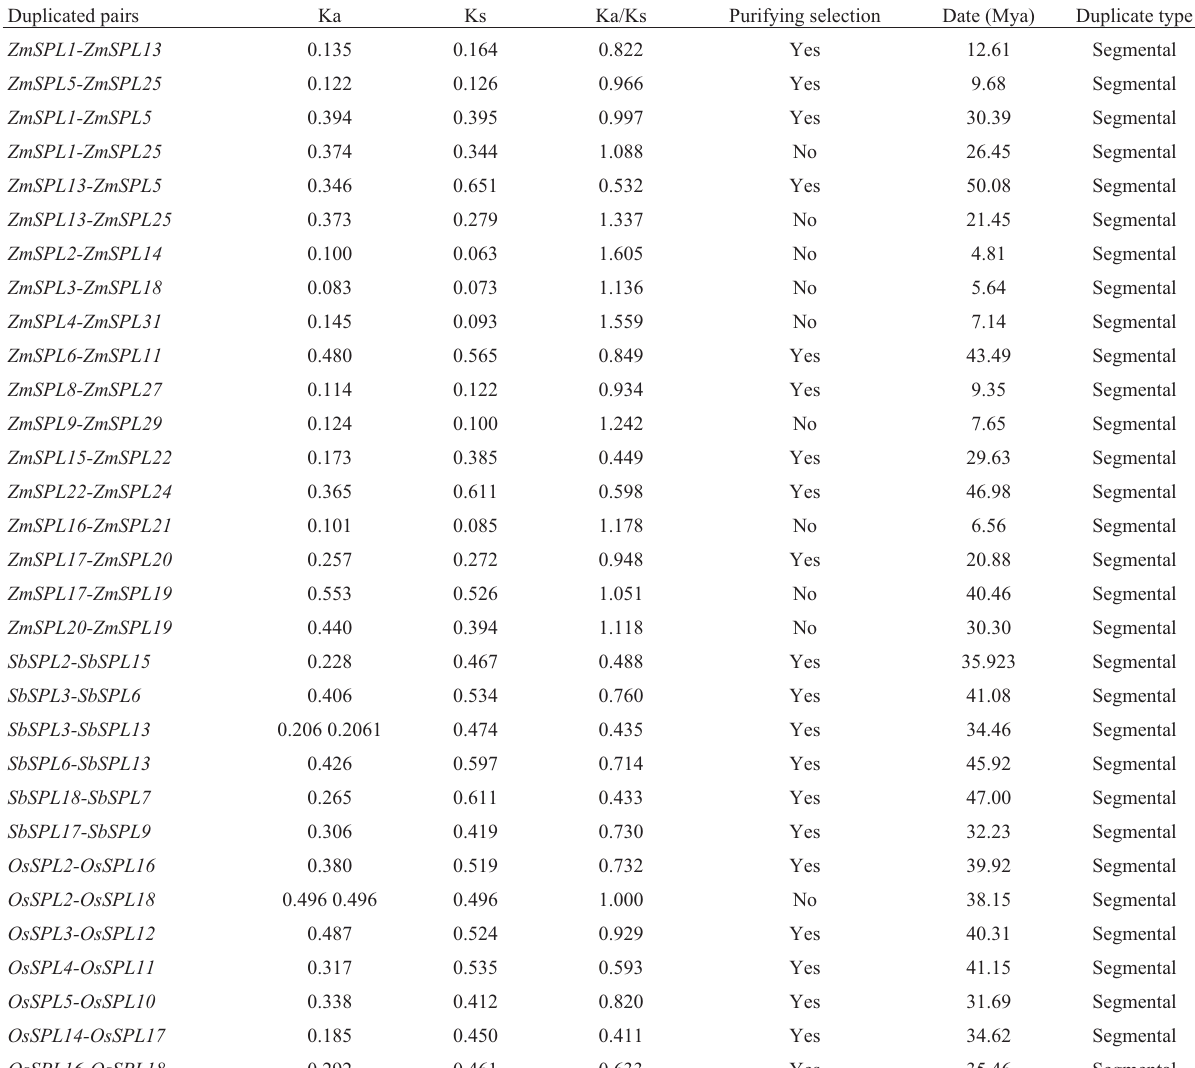
Table 1 - Ka/Ks analysis and estimated divergence time for the duplicated SPL paralogs Duplicated